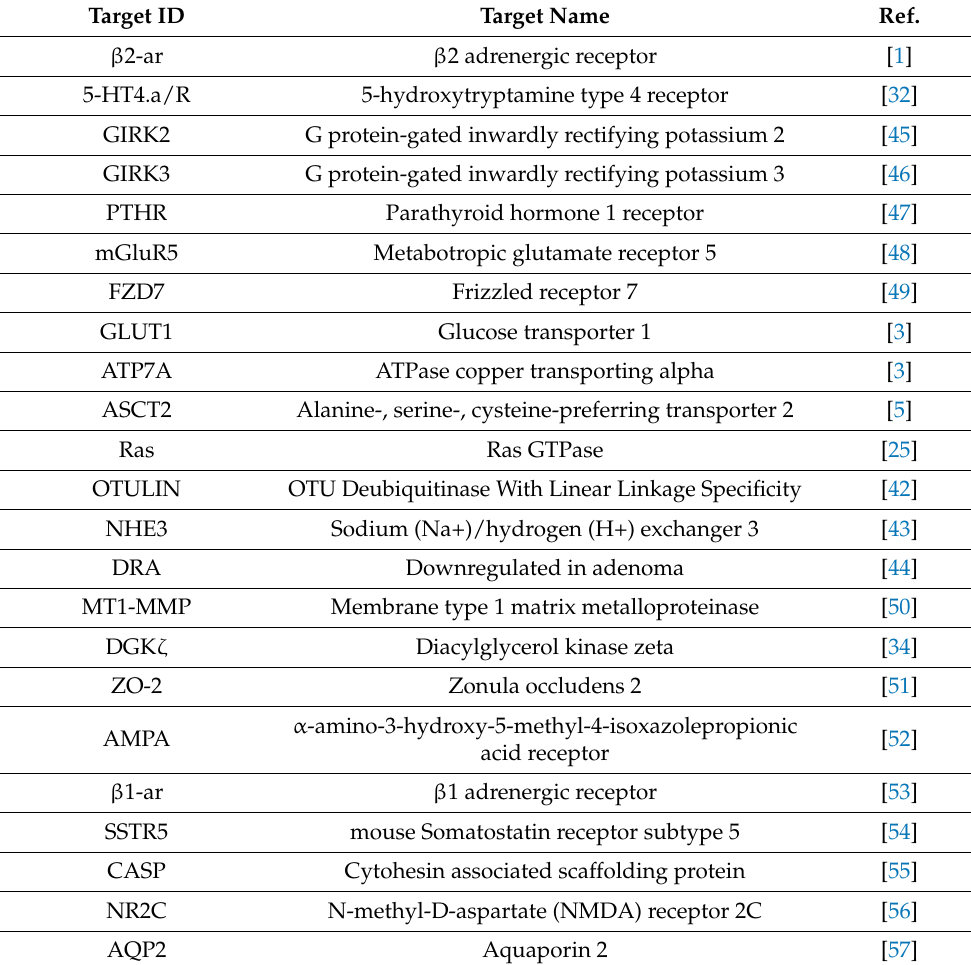
Table 2. Identified binding partners of